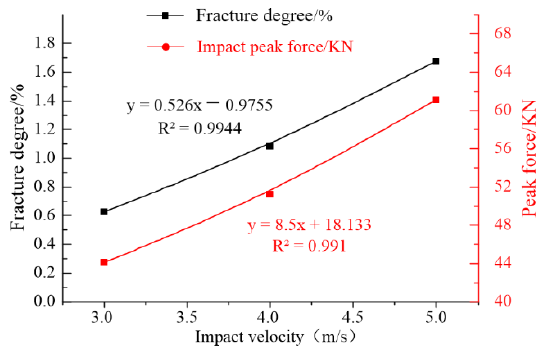
Figure 10. Comparison of the impact force and rupture degree.